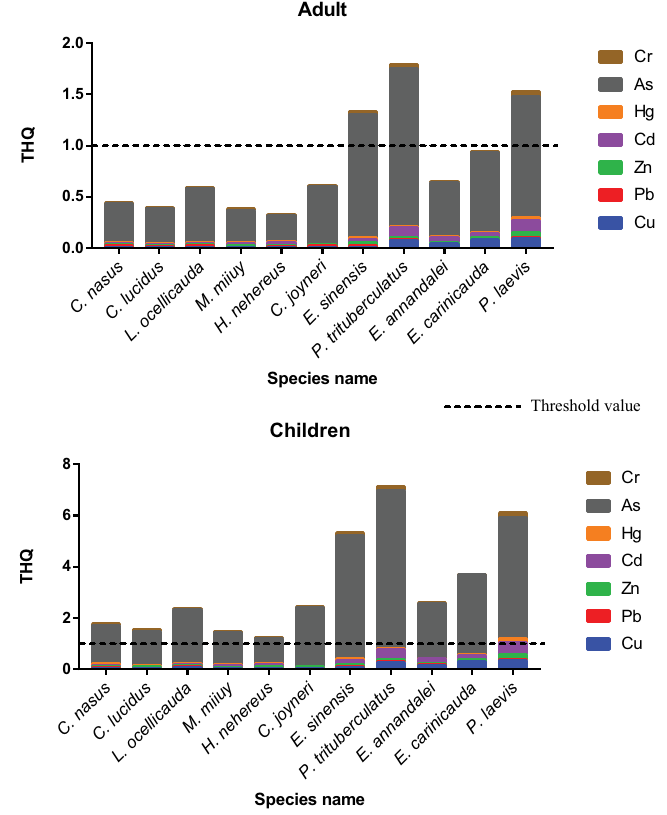
Figure 5. Targeted hazard quotient (THQ) for the children and adult consumer of targeted